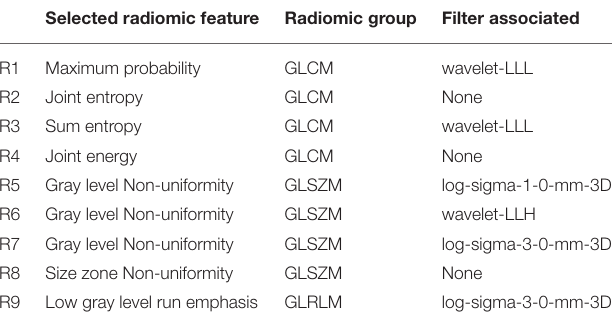
TABLE 2 | Nine selected radiomic